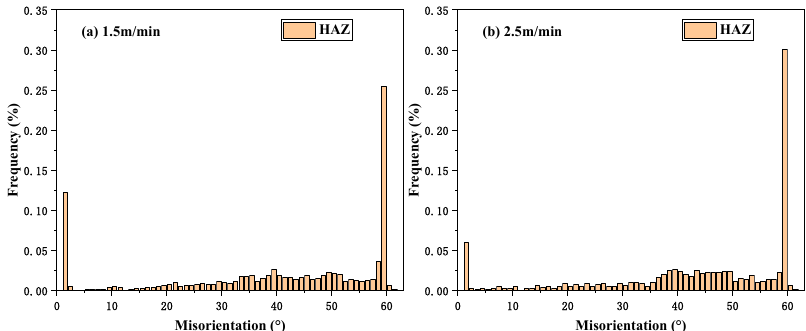
Figure 6. The misorientation distribution of HAZs under the welding speed of ( a ) 1.5 m/min and ( b ) 2.5 m/min.